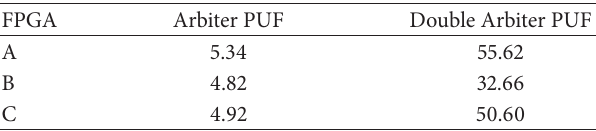
Table 2: Intrachip variation [%] of Arbiter PUF and Double Arbiter